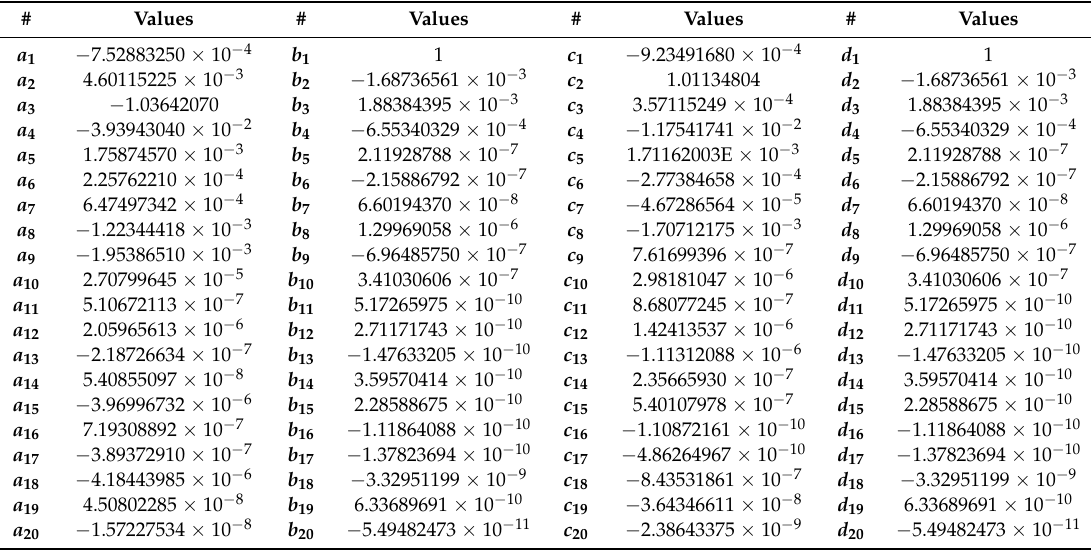
Table 3. Rational function polynomial coefficients of the first study area.